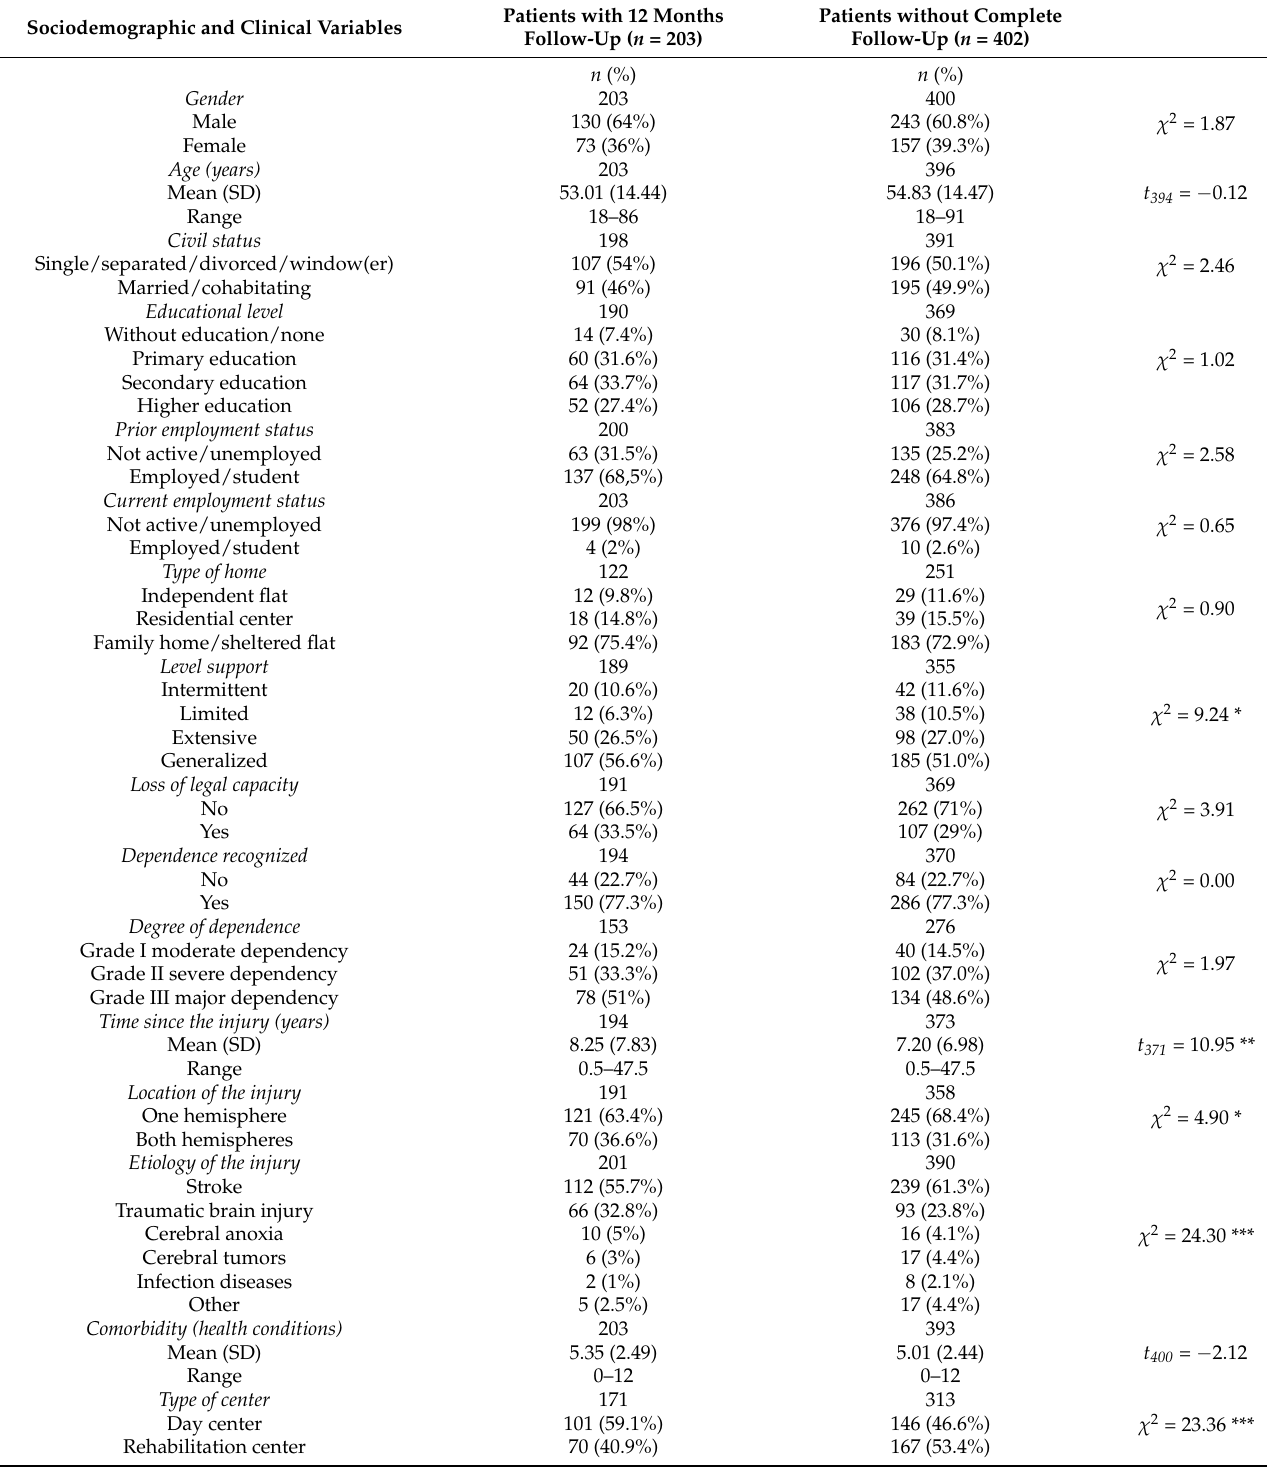
Table 1. Sociodemographic and clinical characteristics of the acquired brain injuries (ABIs) sample. Sociodemographic and Clinical